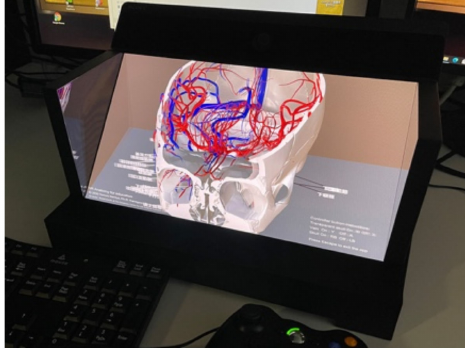
Figure 3. Another example of SR Anatomy.